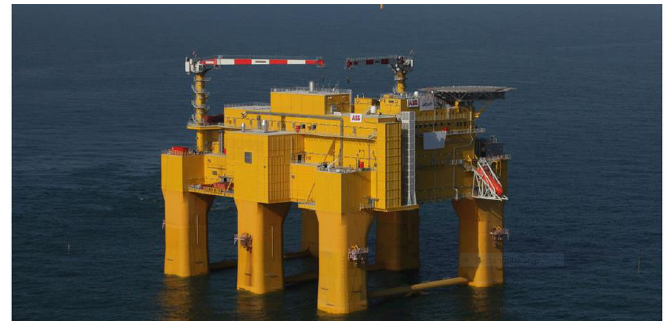
Figure 13. Hitachi Power Grids installation of compact ±320 kV HVDC GIS on offshore platform in the North Sea [59].